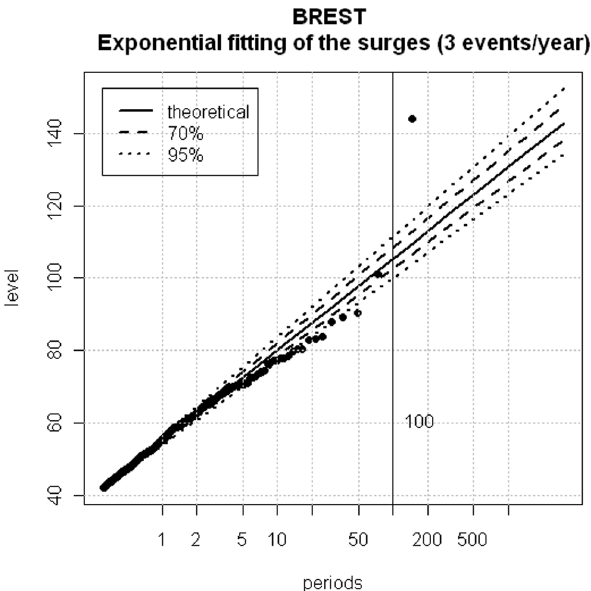
Fig. 2. Location of the different sites of the study, focused on the surges along the Atlantic coast and the Channel